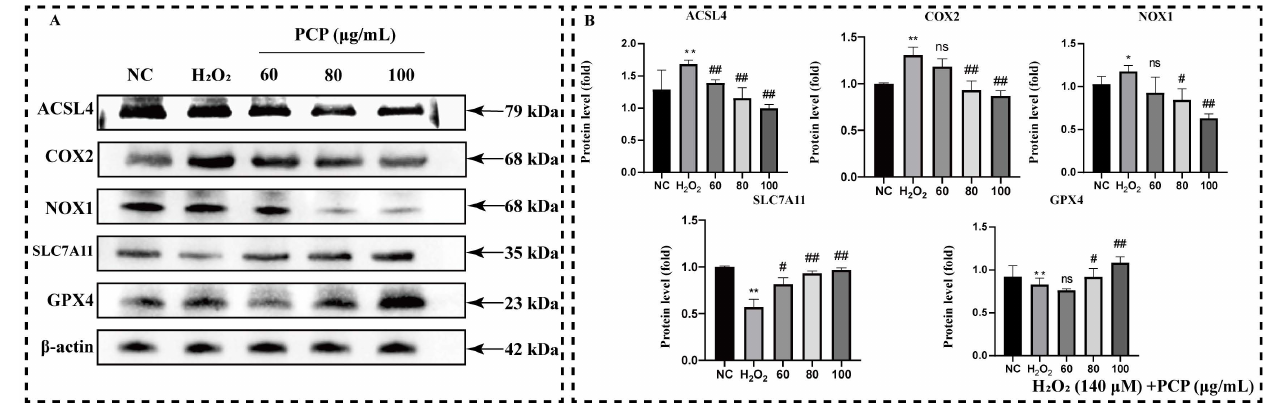
Figure 7. PCP upregulates ferroptosis pathway in microglia. The cells were treated with H 2 O 2 (140 µ mol) and PCP at different concentrations (0, 60, 80, and 100 µ g/mL) for 24 h. We set the NC group treated with DMEM medium as the control. Then, the levels of the ACSL4, COX2, NOX1, SLC7A11, and GPX4 proteins were measured by Western blotting, and the grey value by ImageJ. The levels of the ACSL4, COX2, NOX1, SLC7A11, and GPX4 proteins ( A ). The statistics of the proteins’ grey value after β -actin standardization ( B ). ( ns p > 0.05, * p < 0.05, ** p < 0.01, # p < 0.05, and ## p <